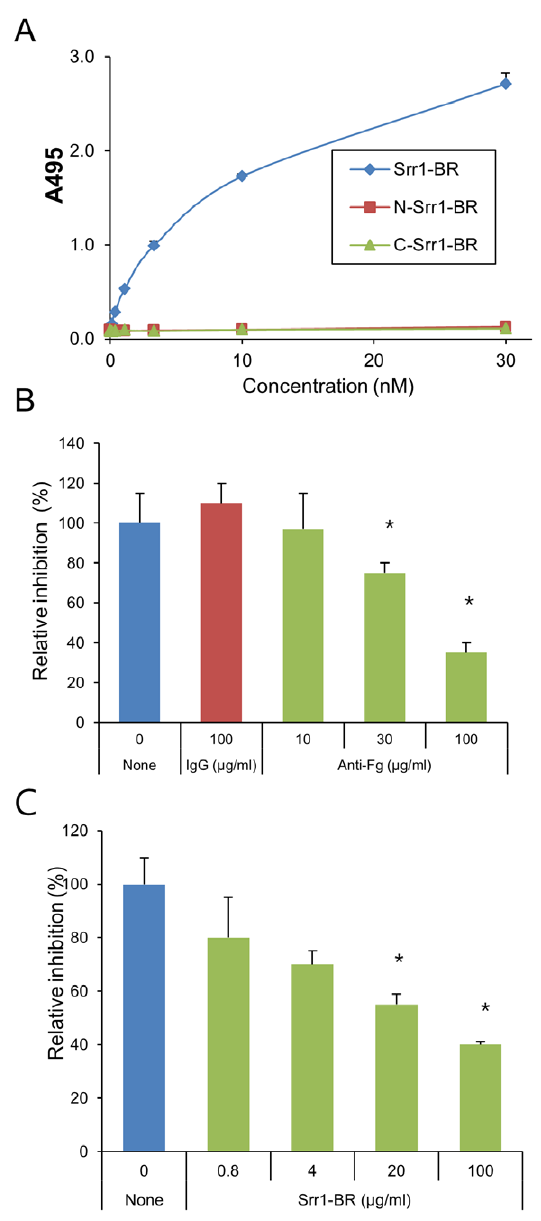
Figure 5. Interaction of the binding region (BR) of Srr1 with fibrinogen. (A) Binding of purified Srr1-BR, N terminal Srr1-BR, or C- terminal Srr1-BR protein ( FLAG Srr1-BR, FLAG N-Srr1-BR, FLAG C-Srr1-BR) to immobilized fibrinogen (0.1 m M). Bound proteins were detected with anti-FLAG antibody. (B) Inhibition of FLAG Srr1-BR binding to immobilized fibrinogen with anti-fibrinogen IgG. Immobilized fibrinogen was preincubated with the indicated concentration of anti-fibrinogen antibody, and then tested for binding by FLAG Srr1-BR (5 m g/ml). Bound proteins were detected with anti-FLAG IgG. Normal rabbit IgG served as a control. (C) Inhibition of FLAG Srr1-BR binding to fibrinogen by unlabeled Srr1-BR. Immobilized fibrinogen was coincubated with the indicated concentrations of FLAG Srr1-BR (5 m g/ml) or unlabeled Srr1-BR. Bound proteins were detected with anti-FLAG antibody. Values represent percent of FLAG Srr1-BR binding to the wells treated with fibrinogen. Bars indicate the means ( 6 S.D.). *=P , 0.01.